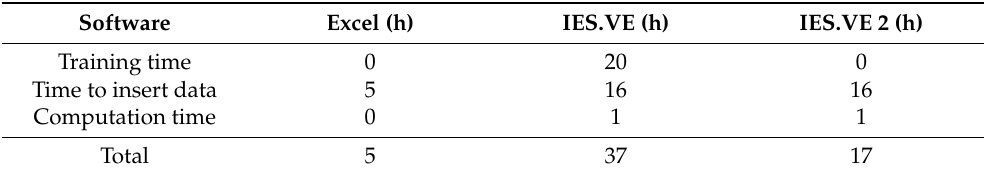
Table 3. Comparison between simplified algorithm, with Excel software, and IES.VE for each SUCA